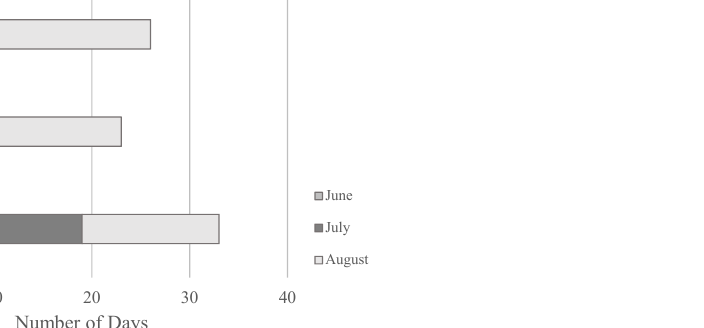
Figure 6. Number of days with daily maximum temperature greater than 30 degrees Celsius in July–August–September from 2018 to 2020.